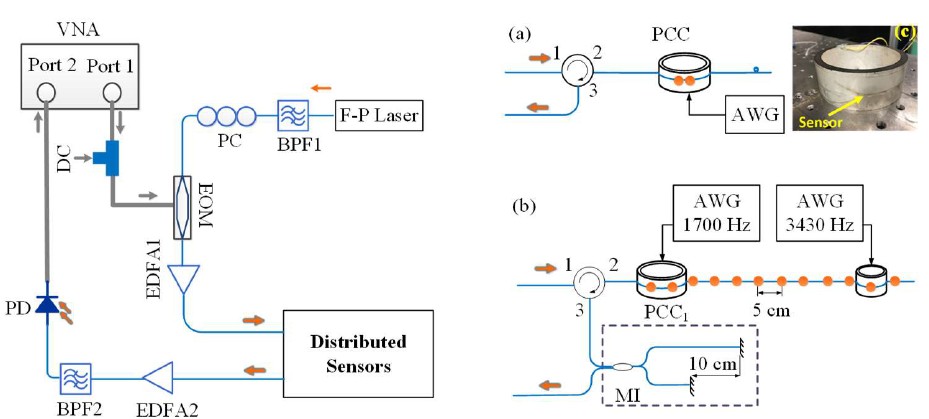
Figure 2. Schematic of the experimental setup for DAS by using CMPI. The optical fiber sensing network was formed by ( a ) a single reflector pair and ( b ) a weak reflector array and a Michelson interferometer. ( c ) Optical fiber with weak reflectors taped around the PCC. PCC: piezo ceramic cylinder; AWG: arbitrary waveform generator, EDFA: erbium-doped fiber amplifier.